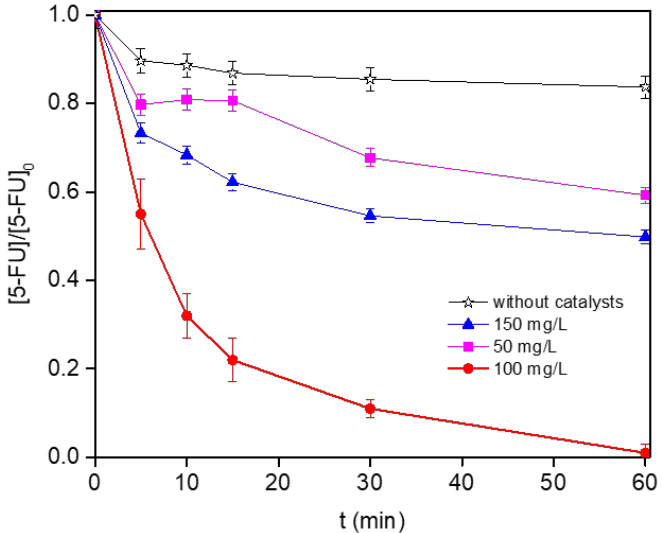
Figure 6. Influence of the catalyst loading on the 5-FU degradation under simulated solar radiation.